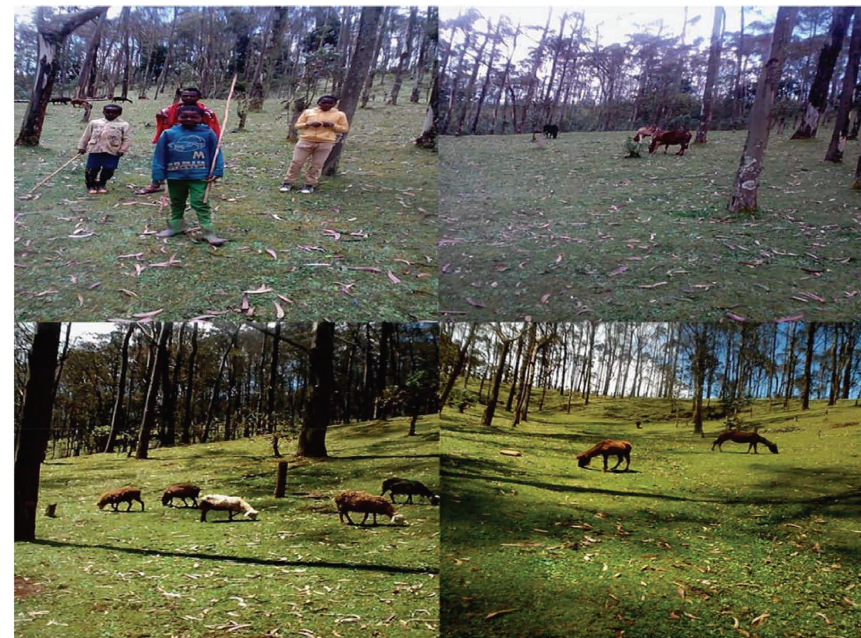
Figure 3: Grazing under the plantation forest (upper left: cowboys) (source: flmed from the feld, 2021).